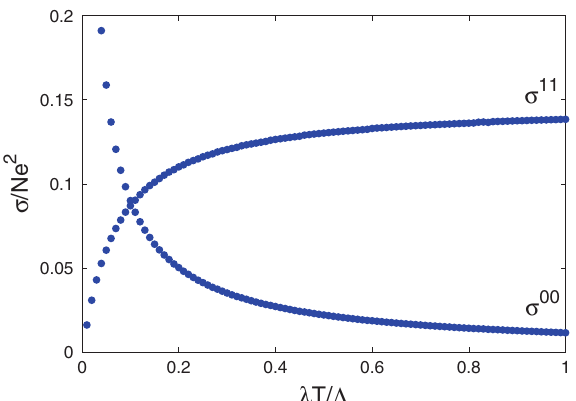
Fig. 3 The σ 00 and σ 11 conductivities per band. σ 00 falls as 1/ T (although with different proportionality constants) in both tem- perature ranges ω 0 ≪ T ≪ μ / λ and μ / λ ≪ T ≪ μ . σ 11 grows in the lower range of T , then saturates as it approaches the value e 2 /2 π in the higher. This is calculated for a two-dimensional tight binding model, in which the phonon displacement couples to the nearest-